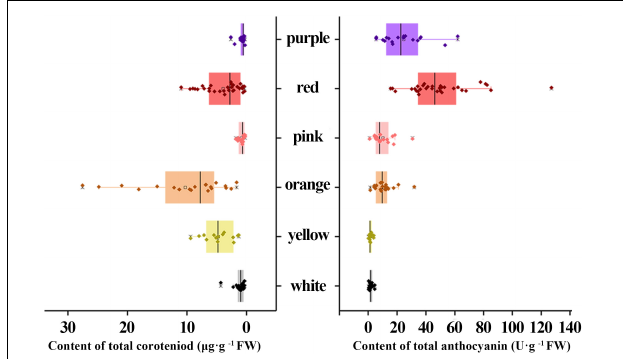
FIGURE 3 | Comparison of the contents of total carotenoid (Ct) and total anthocyanin (At) in different color groups.